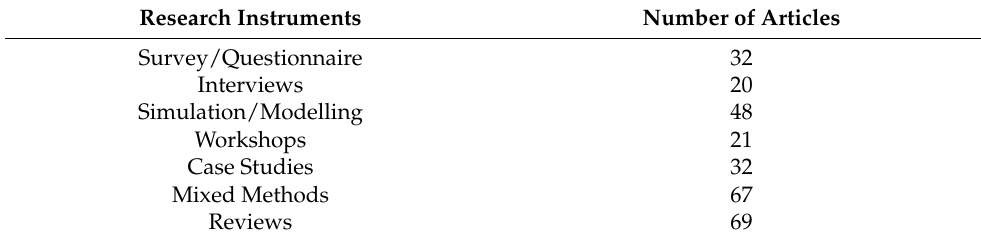
Table 2. Distribution of research instruments in the FOCIT